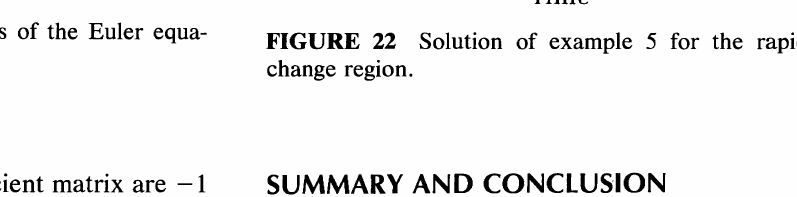
FIGURE 22 Solution of example 5 for the rapid change region.